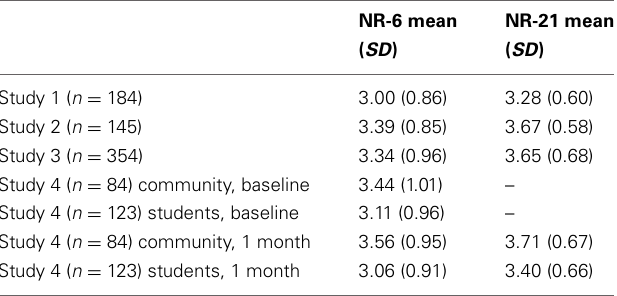
Table B1 | Nature relatedness scales—means and standard